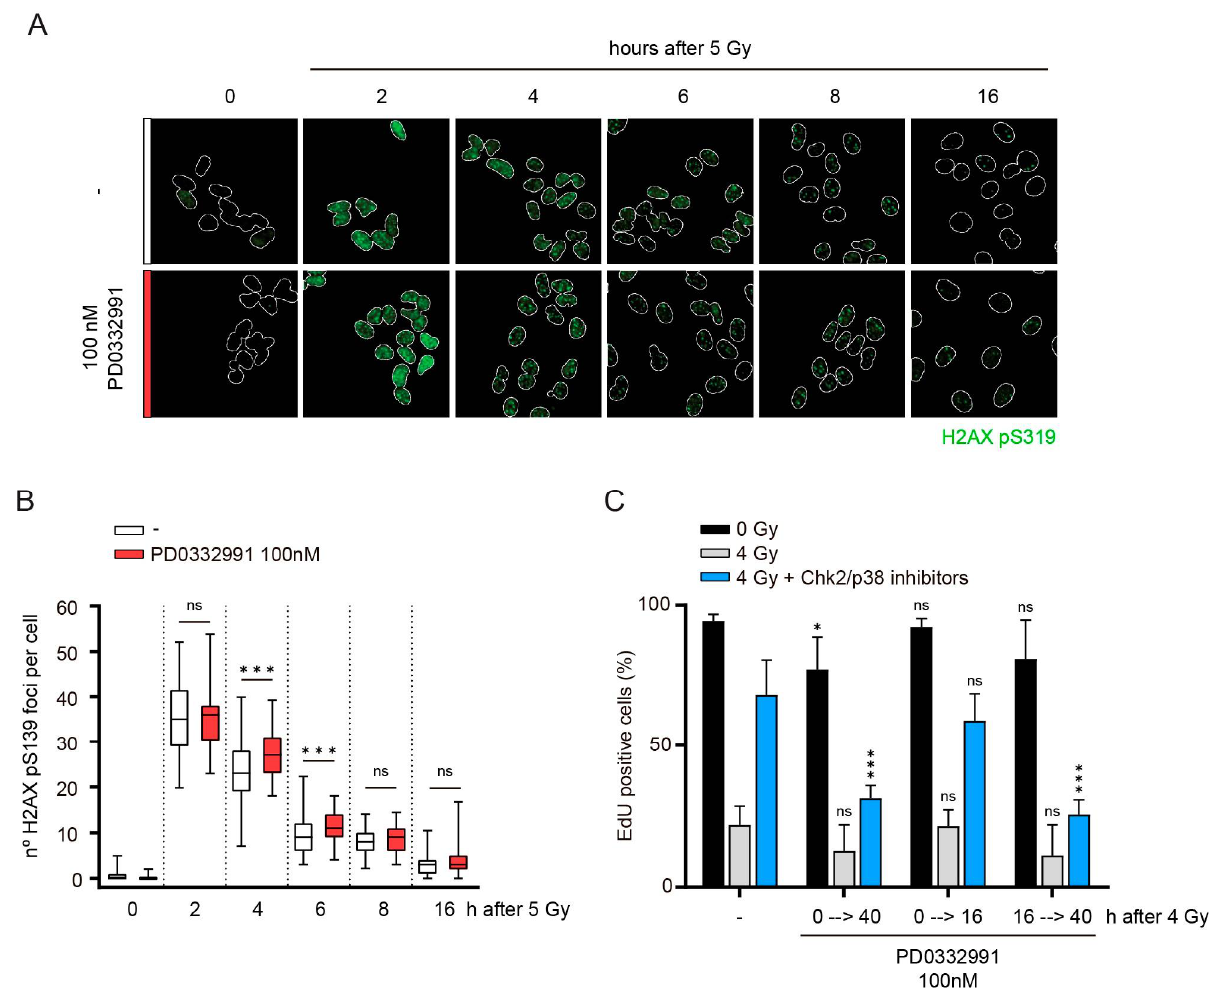
Figure 2. Cdk4/6 activity is not required during a G1 arrest: ( A ) RPE-1 cells synchronized in G1 were irradiated and stained for H2AX pS139. White outlines demarcate nuclei based on DAPI counterstains. ( B ) Quantification of H2AX pS139 foci in ( A ) using previously developed image analysis software (Warmerdam et al., 2019). Whiskers represent 5–95% of data points. At least 40 cells were quantified per condition. ( C ) Cells were treated as in 1A. Two different doses of Cdk4/6 inhibitor PD0332991 were applied either throughout the first 16 h of the experiment (0 → 16), throughout the experiment (0 → 40) or from the moment of Chk2 and p38 inhibitor addition (16 → 40). Depicted are means and SD from three independent experiments. Significance was calculated by comparing different drug regimens to control cells of similar irradiation regimen (e.g., 4 Gy irradiated and PD0332991-treated samples (0 → 40) were compared to 4 Gy irradiated cells that were not treated with PD0332991). For all panels, significance was calculated using a one-sided unpaired t -test. * p < 0.05, *** p < 0.005, ns = not